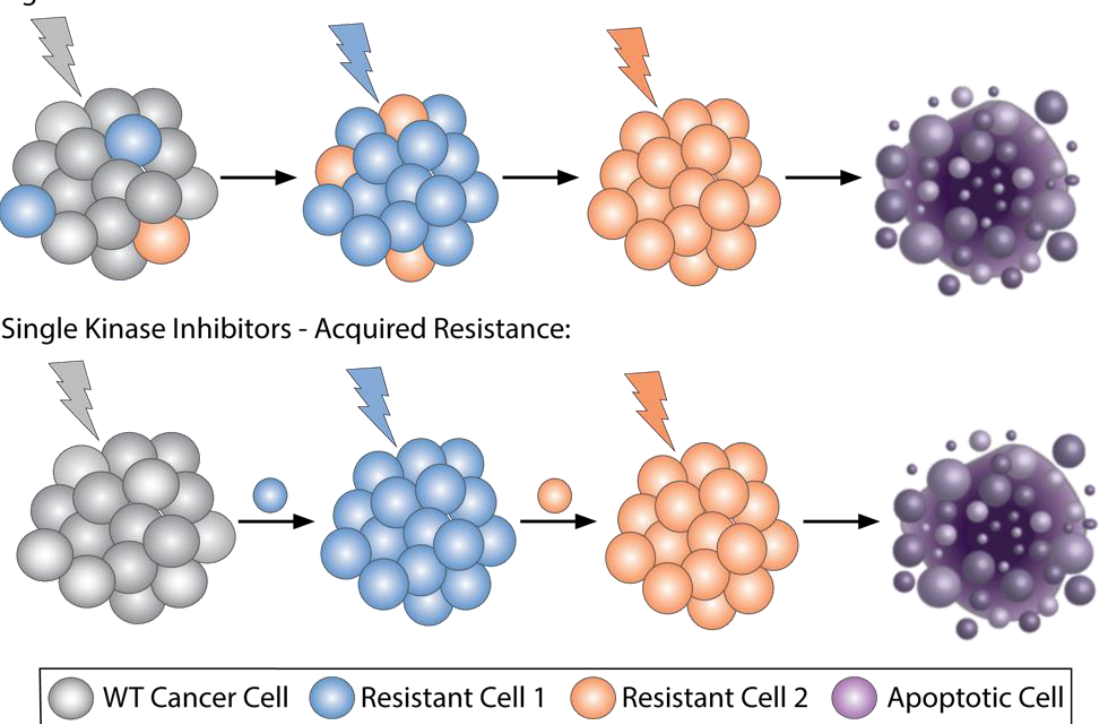
Figure 1. Types of resistance mechanisms occurring in patients. Resistance to targeted therapies can be broadly classified as either de novo or acquired resistance. In case of de novo resistance (top), pre-existing mutations exist in tumor cells that are selected for after treatment (blue colored cells). This could potentially be overcome by treating with sequential selective kinase inhibitors that target escape mechanisms of resistance (orange-colored cells). In acquired resistance (bottom), cells with resistance arise during treatment and cause relapse. Sequential treatments may overcome resistance if given in correct order.